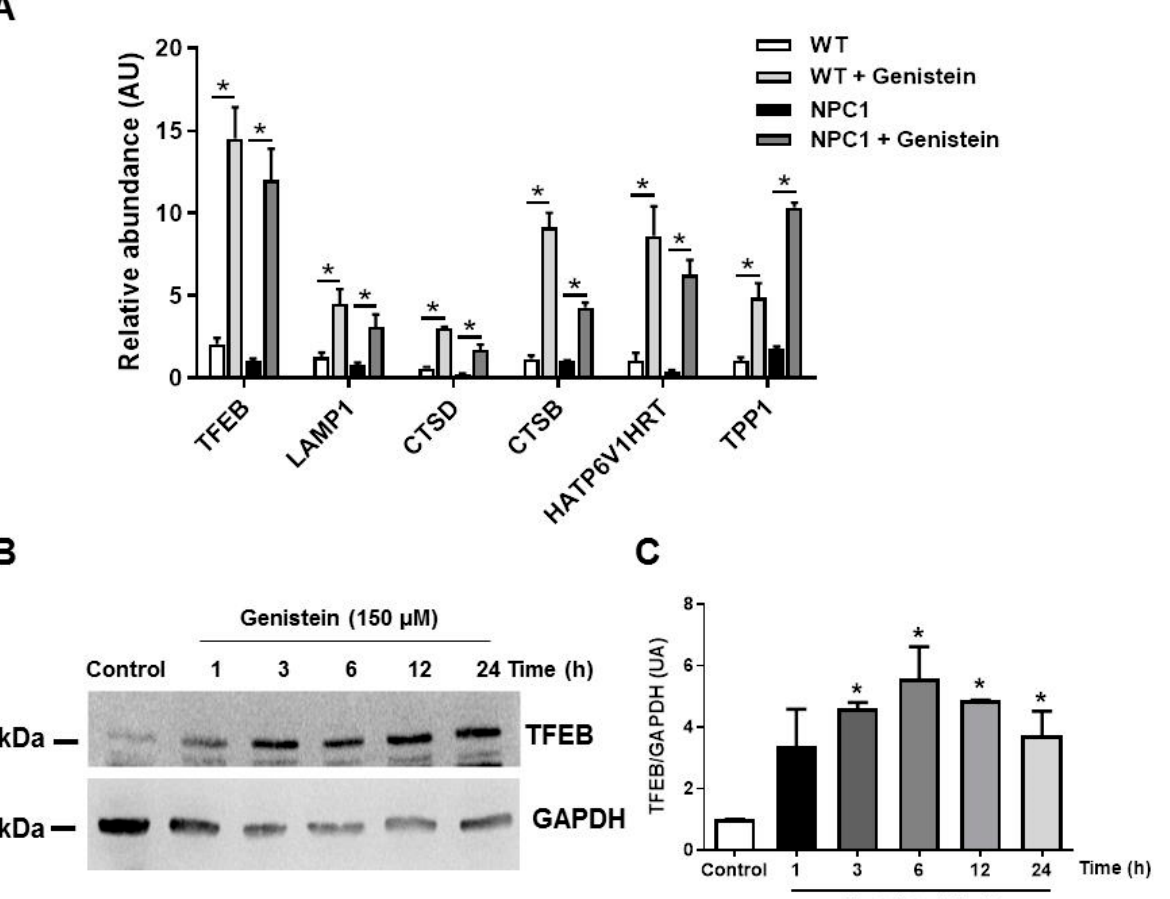
Figure 2. Genistein induces the mRNA expression of transcription factor EB (TFEB)-target genes and increases TFEB levels in NPC1 patient fibroblasts. ( A ) The graph shows qPCR analysis of mRNA levels of different TFEB target genes in GM05659 wild type (WT) fibroblast and GM03123 NPC1 patient fibroblasts after 24 h treatment with 150 µM of genistein. The bar graphs represent the relative fold induction of these genes normalized with GAPDH mRNA levels. Representative immunoblot ( B ) and quantification ( C ) of endogenous TFEB total levels in lysates from WT fibroblast and NPC1 patients fibroblast obtained after 1, 3, 6, 12, and 24 h treatment with 150 µM of genistein. GAPDH was used as a loading control. Data were presented as mean ± SEM of three independent samples (each with triplicates), * p ≤ 0.05, analyzed by ANOVA with Tukey posttest, n = 3 for each experiment (in triplicates for genes).